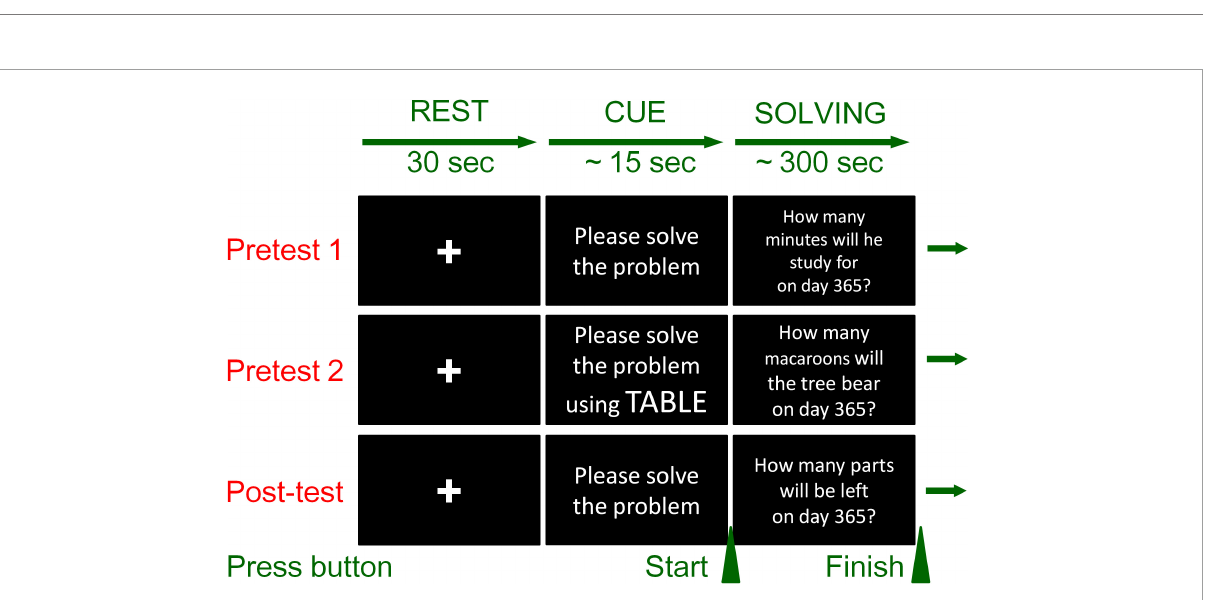
FIGURE1 Test condition and procedure. Example of Group A (problems presented depends on the group; see Table 1 ). The procedures for all three test sessions were the same. Only in pretest 2 was the prompt to solve using the table given in the clue